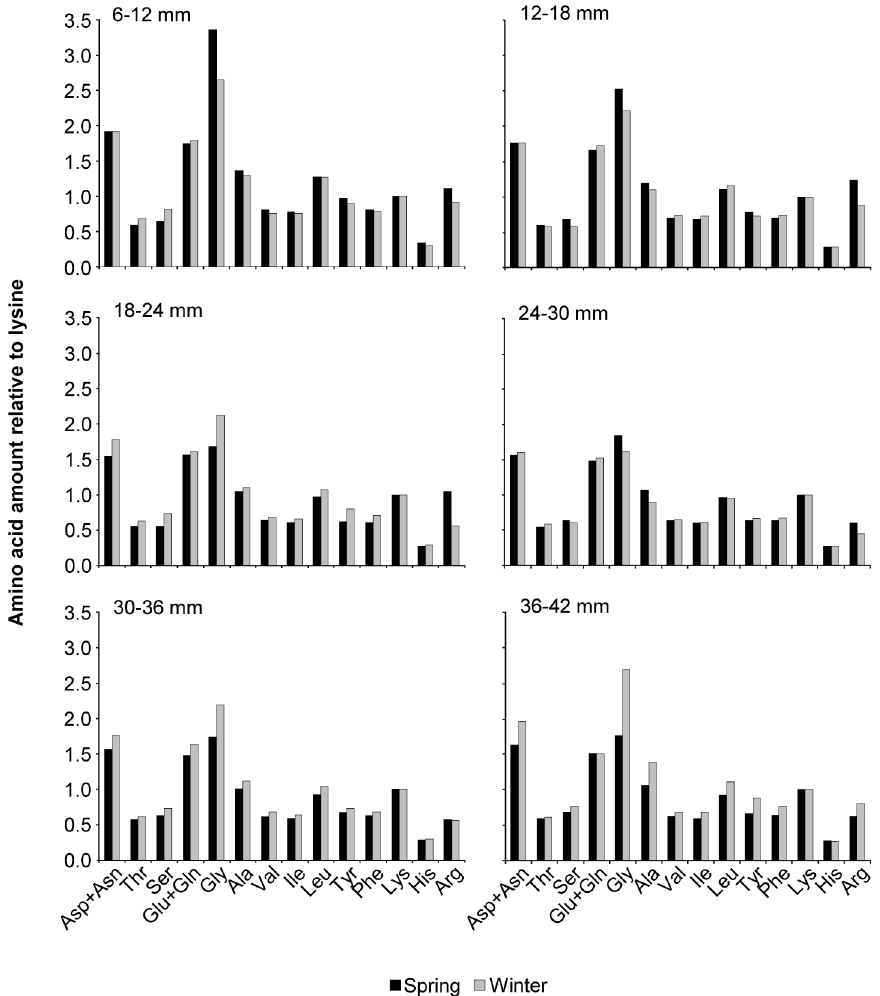
Fig 5. Amino acid amounts relative to lysine for six size classes of Ischadium recurvum . Amino acid amounts relative to Lysine for each size class (6 – 12, 12 – 18, 18 – 24, 24 – 30, 30 – 36, 36 – 42 mm) of Ischadium recurvum collected from the Chesapeake Bay in spring and winter 2007. Asp = Aspartic acid; Asn = Asparagine; Thr = Threonine; Ser = Serine; Glu = Glutamic acid; Gln = Glutamine; Gly = Glycine; Ala = Alanine; Val = Valine; Ile = Isoleucine; Leu = Leucine; Tyr = Tyrosine; Phe = Phenylalanine; Lys = Lysine; His = Histidine; and Arg =